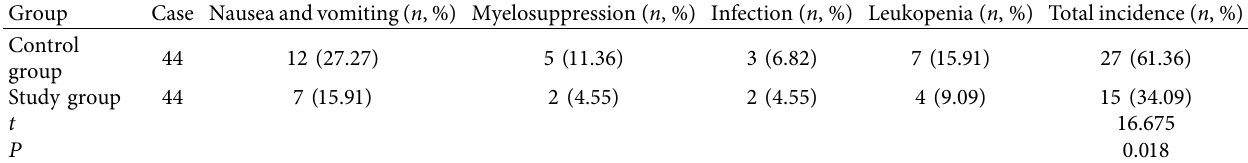
Table 4: The incidence rate of adverse reactions in AML patients following intravenous administration of cytarabine supplemented with either idarubicin or